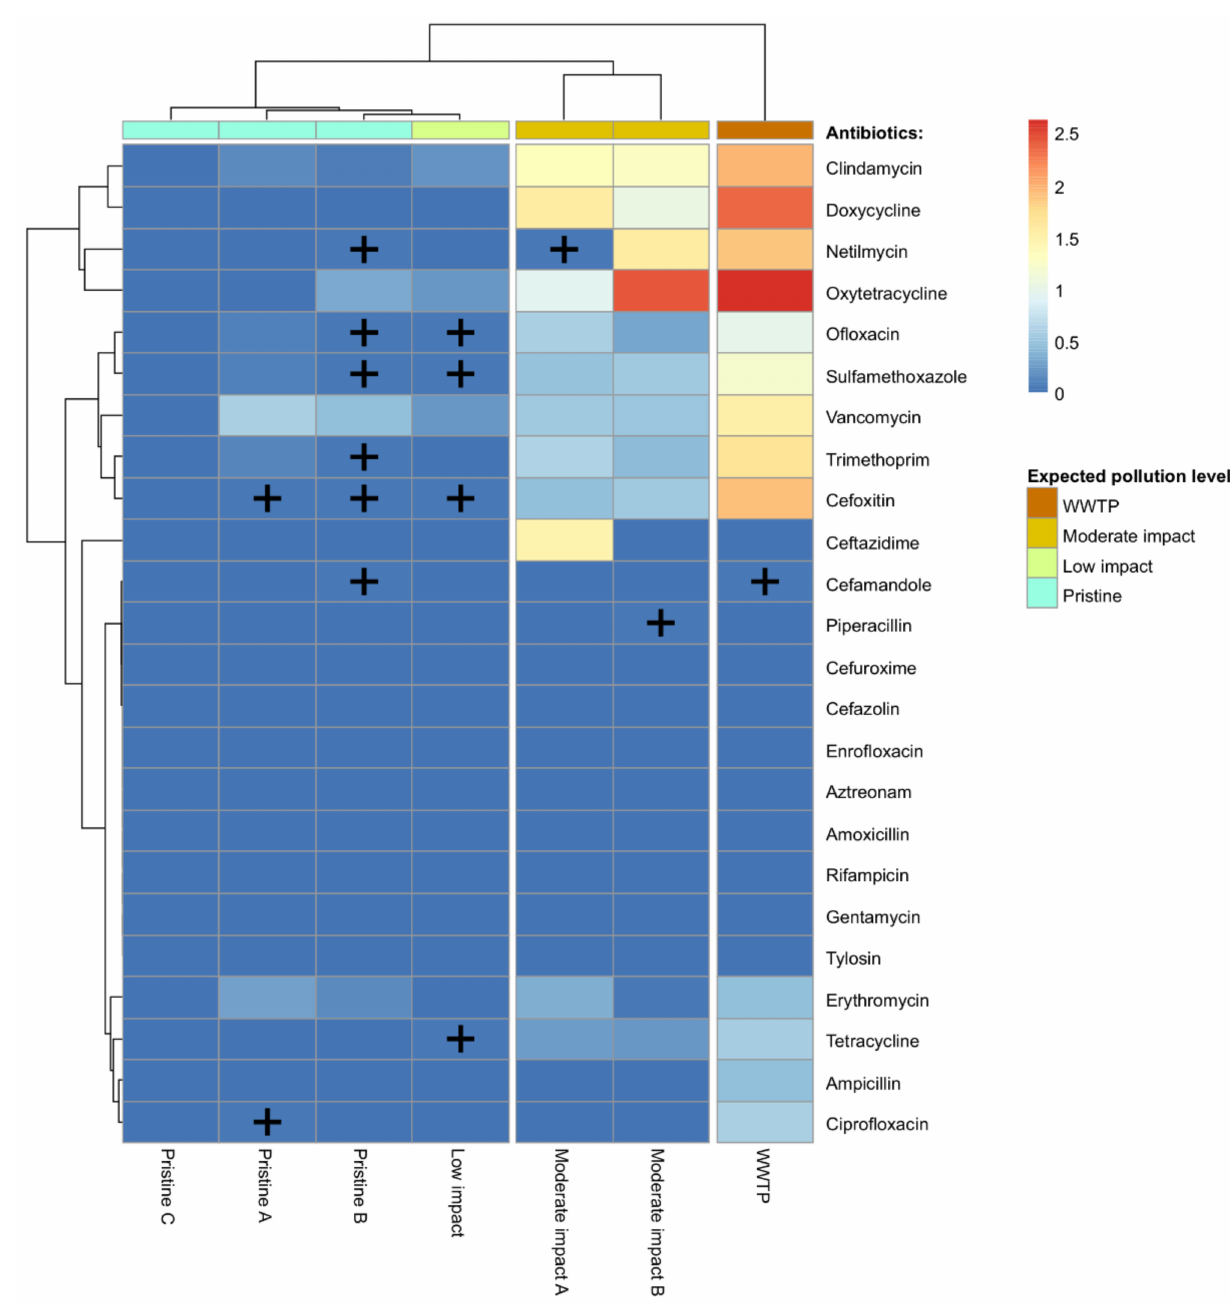
Figure 4. Antibiotic concentration heatmap constructed on the basis of log10+1 transformed data for 24 antimicrobial agents examined in this study, all dates combined. Please note the clear clustering of the sites corresponding to the expected anthropogenic pressure put on the water environment, reflected in the concentration of antibiotics. The “+” sign indicates the antimicrobial agents the presence of which was detected (i.e. exceeded the LOD) but did not exceed the LOQ